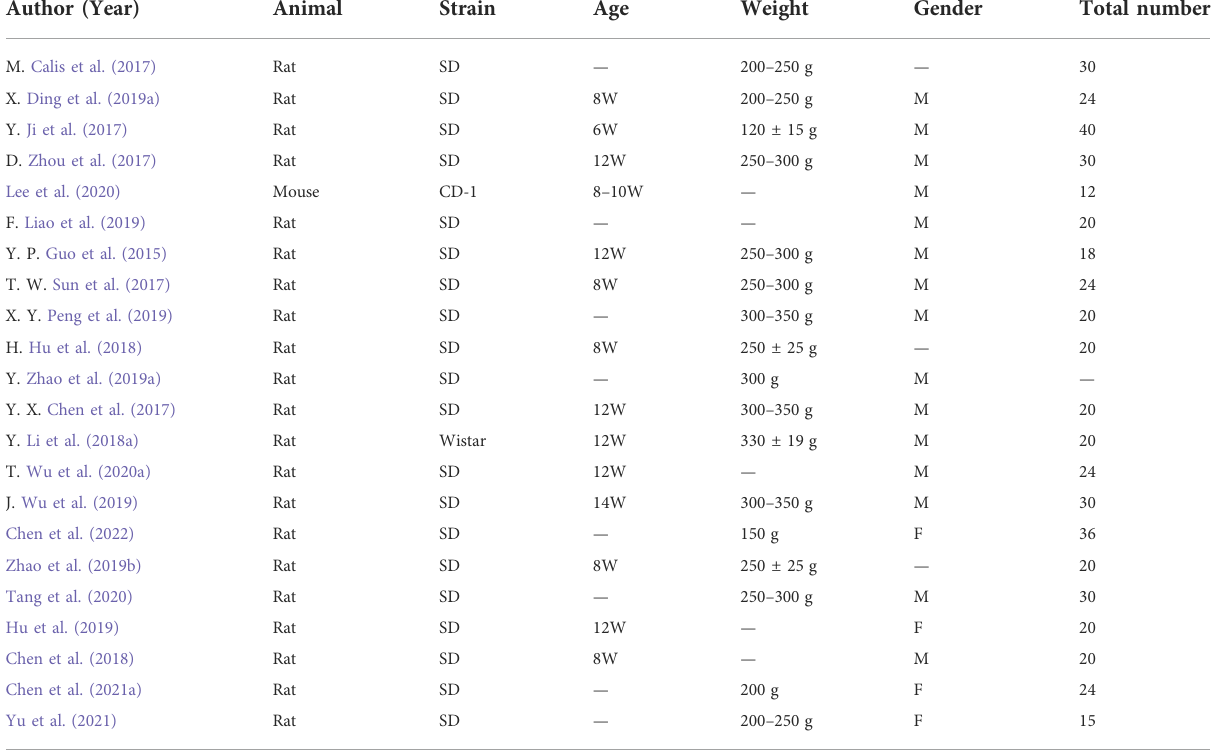
TABLE 4 Baseline characteristics of study subjects. SD: Sprague – Dawley; W: weeks; M: